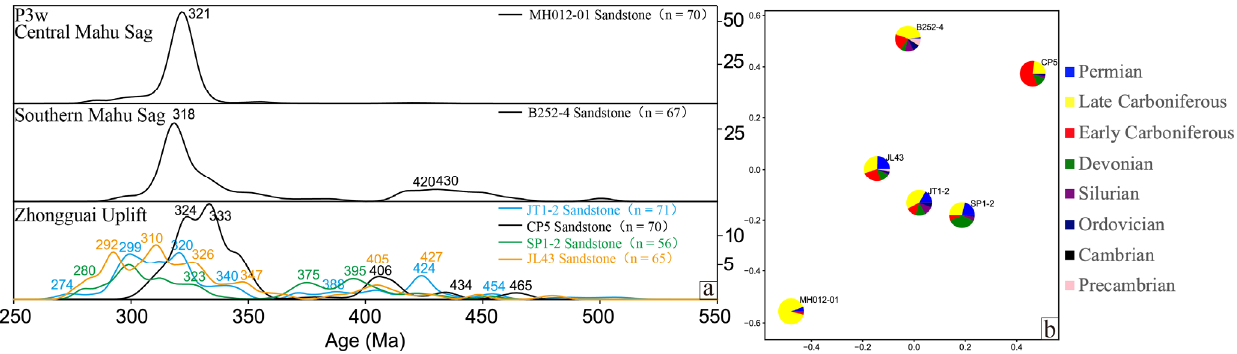
Figure 10. ( a ) Diagram of U-Pb detrital zircon age distribution in the Upper Wuerhe Formation in the Mahu-Zhongguai area, northwestern Junggar Basin. ( b ) Multidimensional scaling diagram. The samples were grouped according to the similarity in age distribution characteristics and geographical location. The multi-dimensional scaling diagram shows the similarity of multiple samples in different locations but in the same period. The locations and details of detrital zircon samples are shown in Figure 1 and listed in Table 1.